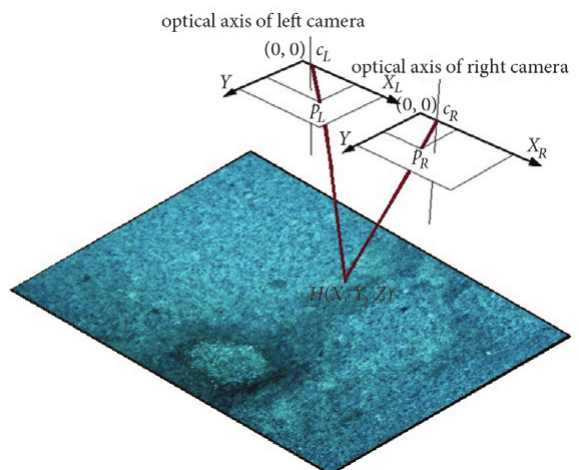
Fig. 2. Model of canonical system of stereo vision measurement